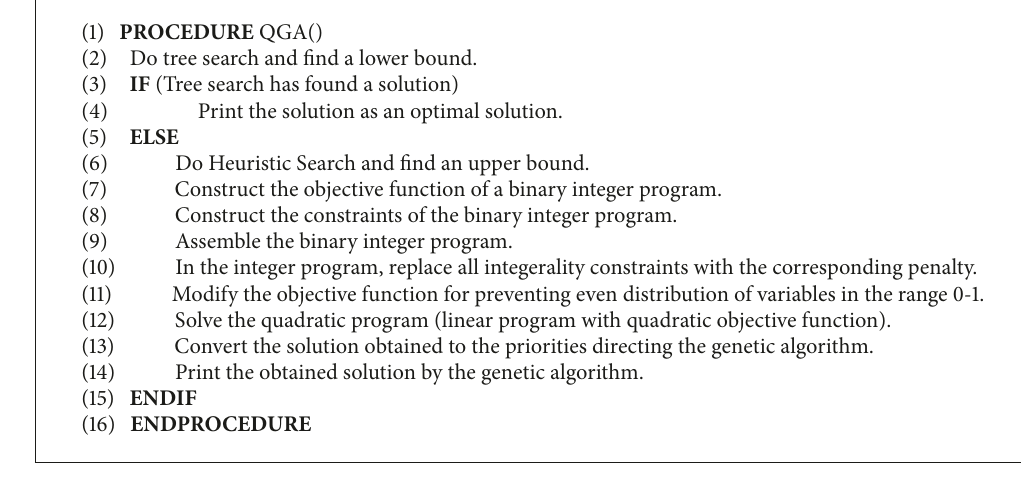
Algorithm 1: The pseudocode of the QGA.